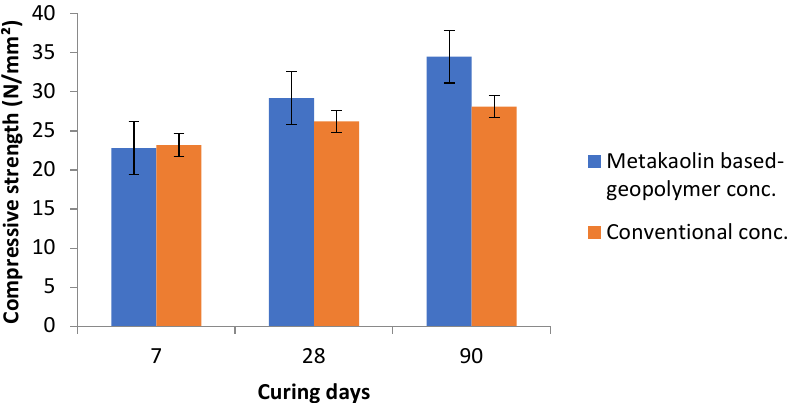
Figure 11. Compressive strength comparison of metakaolin-based geopolymer concrete and ordinary Portland cement concrete.